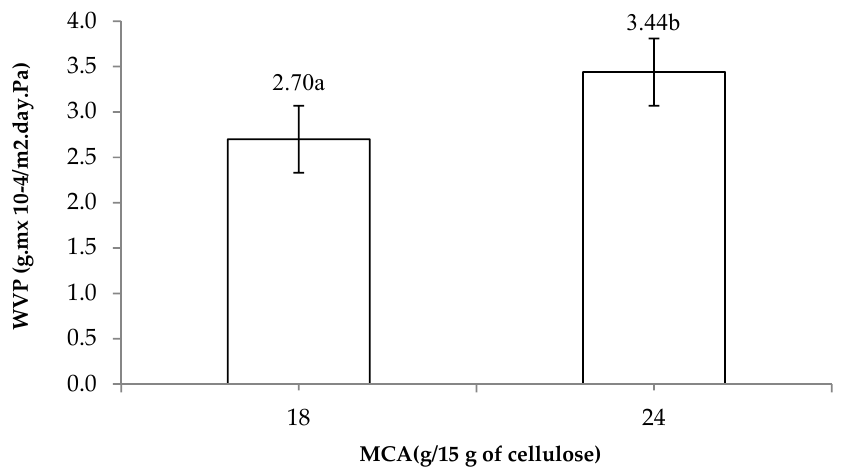
Figure 7. Effects of MCA levels on water vapor permeability (WVP) of CMC n film. The different